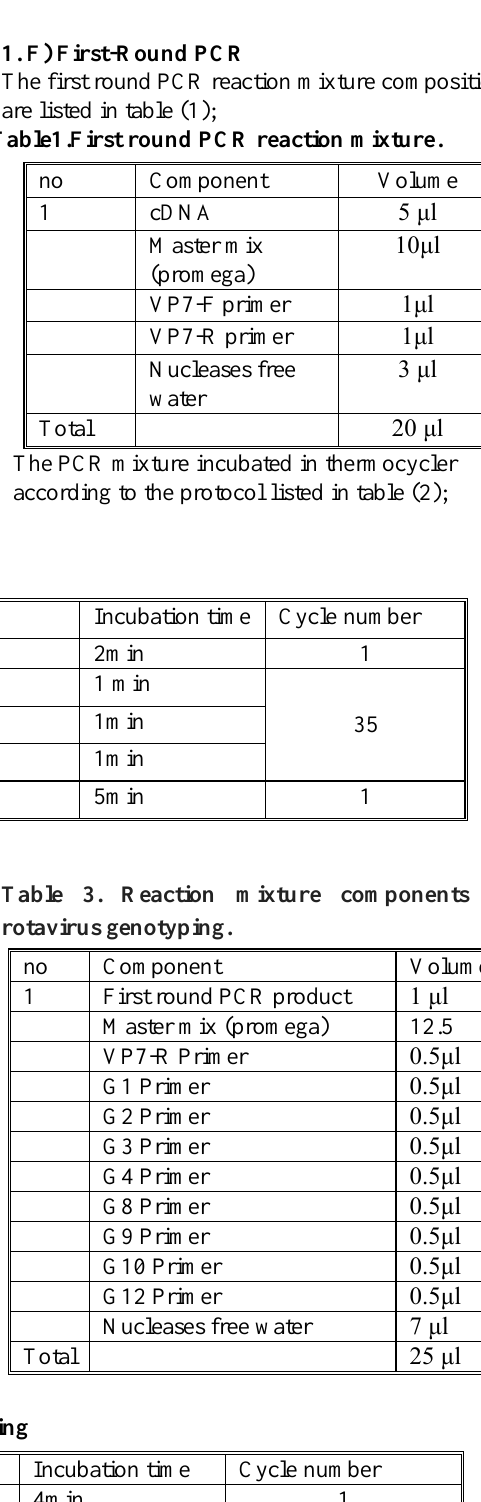
Table 4. Thermocycling conditions for rotavirus genotyping